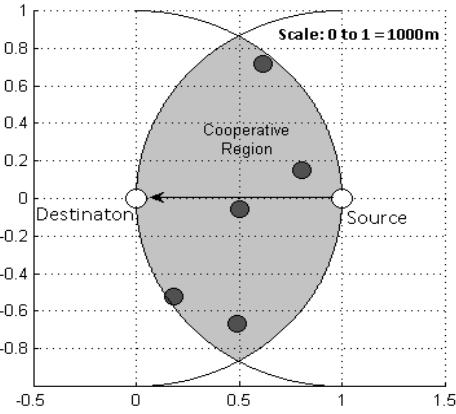
Figure 8. Network settings for BER analysis.